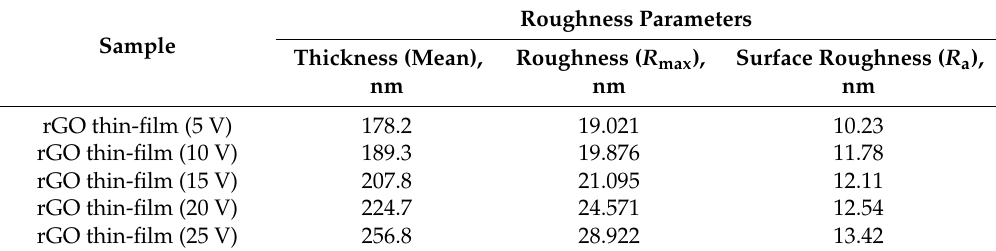
Table 2. Surface analysis of rGO thin-films prepared at 5, 10, 15, 20, and 25 V by electrochemical reduction for 5